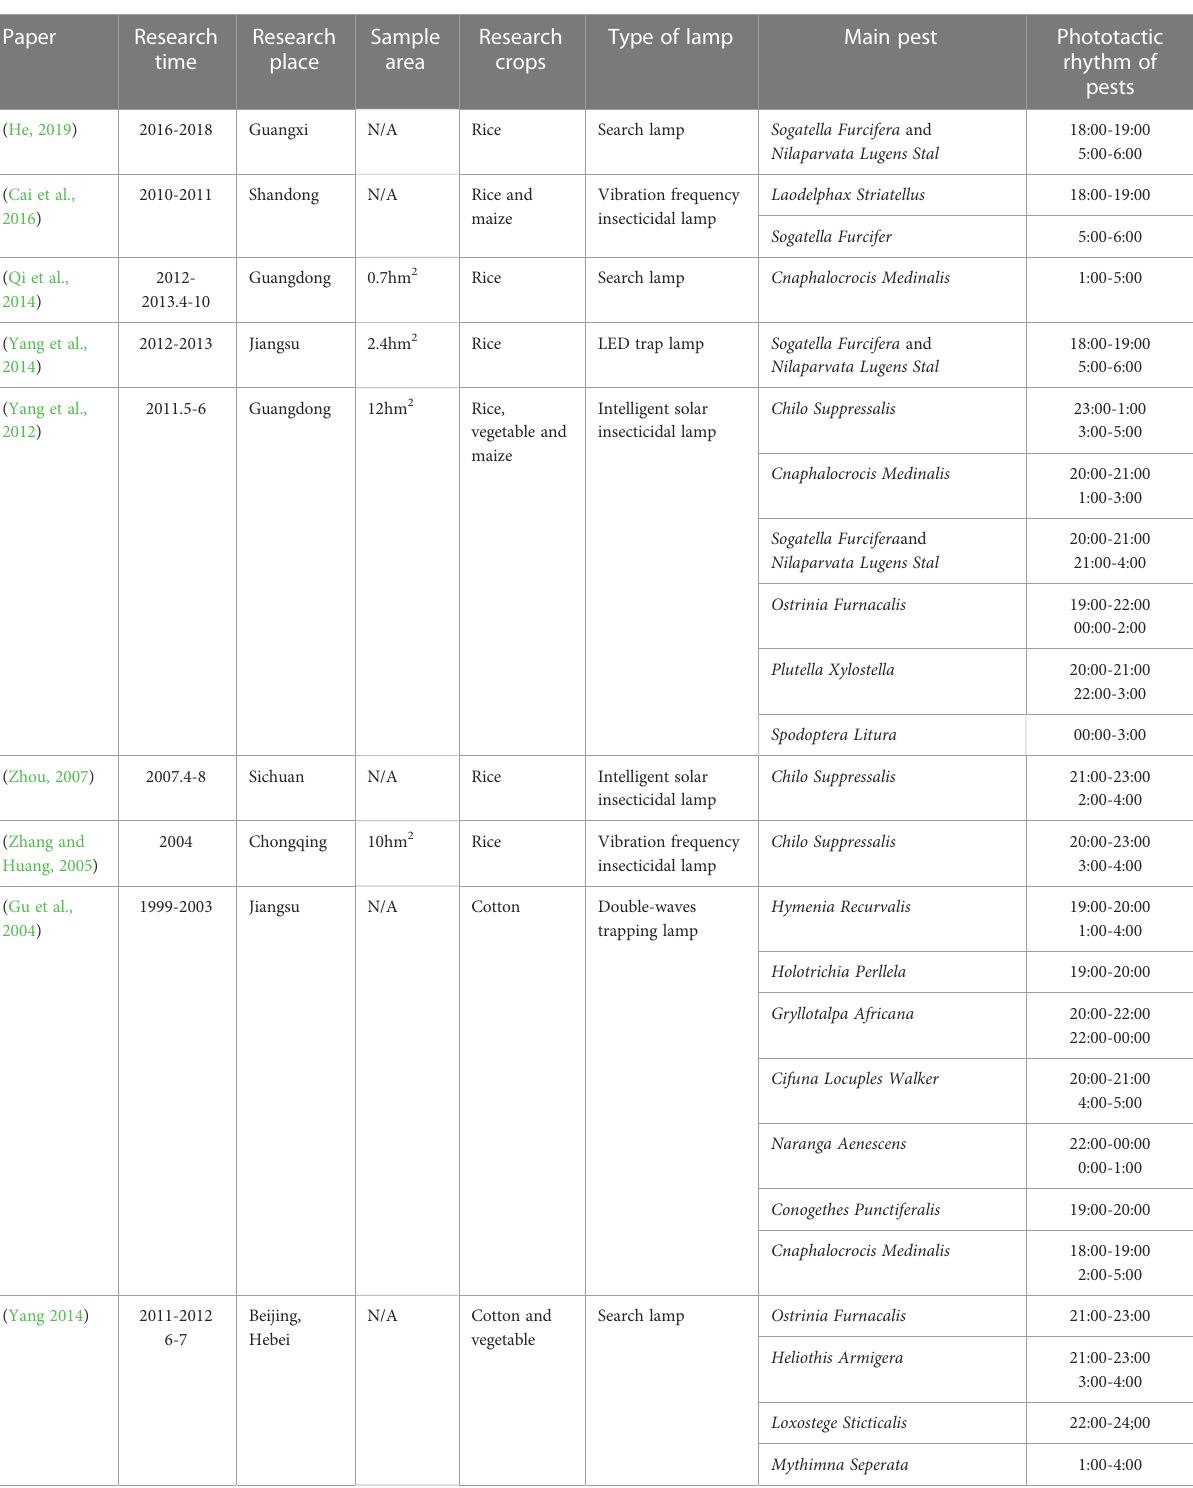
TABLE 4 The phototactic rhythm of main pests in different crops.